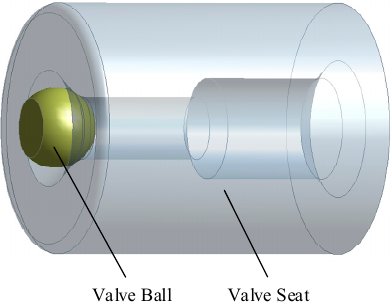
Figure 7. The simulation structure of the pressure relief valve.